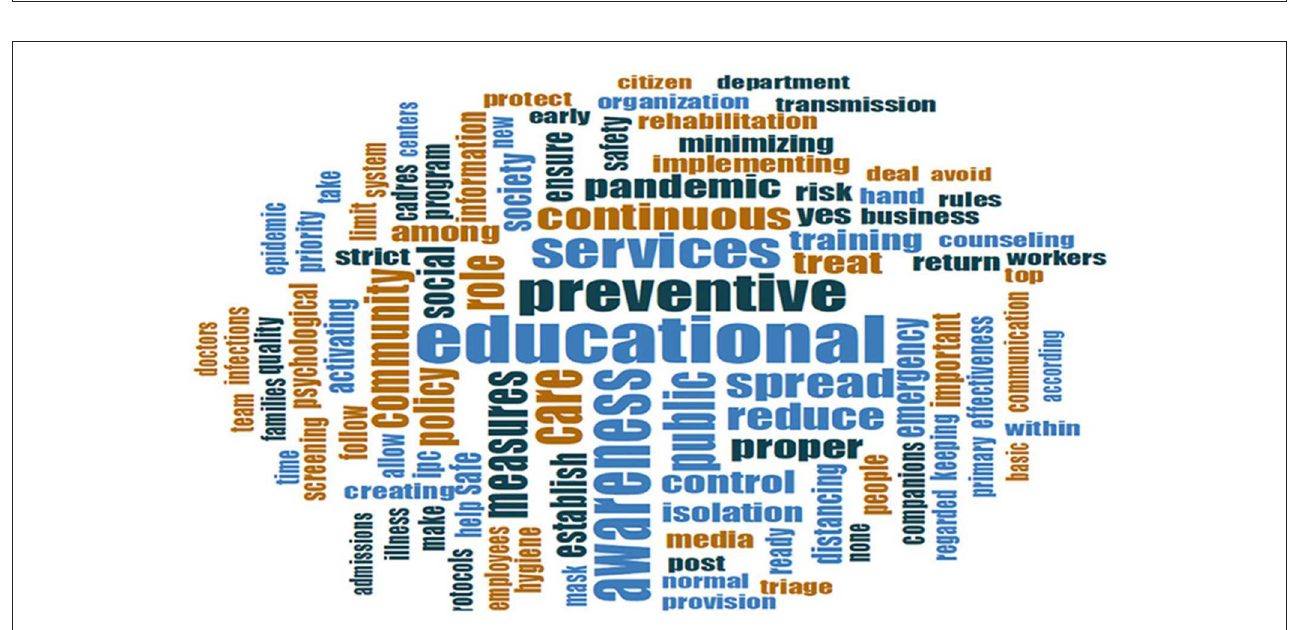
FIGURE2 Word cloud of qualitative responses on role of hospitals in recovery from